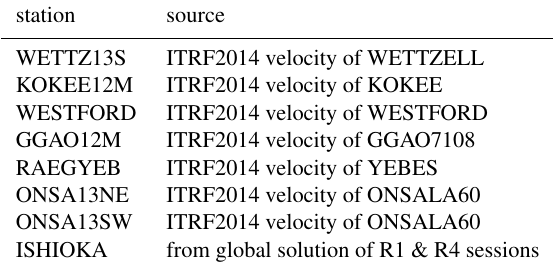
Table 1. Sources of station velocities. The velocity for all but one station was taken from corresponding S/X stations except for ISH- IOKA, where the velocity was derived from R1 and R4